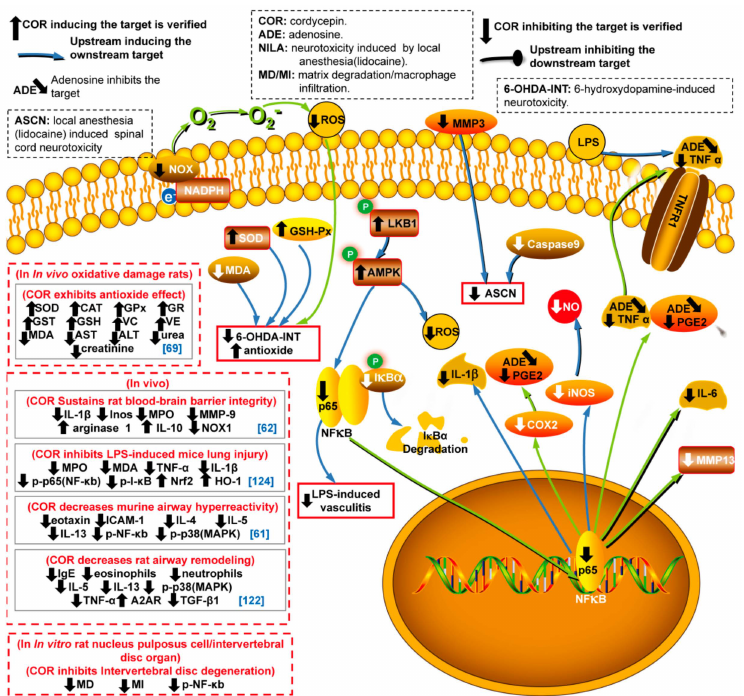
Figure3. Anti-inflammatoryandanti-oxidanttargetsa ff ectedbycordycepinviavarioussignalpathways. Note: SOD: superoxide dismutase. GSH-Px: glutathione peroxidase. MDA: malondialdehyde. 6-OHDA-INT:6-hydroxydopamine-induced neurotoxicity. VC: Vitamin C. VE: Vitamin E. IL-1 β : interleukin-1 beta. iNOS: inducible nitric oxide synthase. PGE2: prostaglandin E2. NO: nitric oxide. COX-2: cyclo-oxygenase. NF- κ B: nuclear factor kappa-B. iNOS: inducible nitric oxide synthase. IgE: immunoglobulin E. ICAM-1: intercellular cell adhesion molecule-1. HO-1: heme oxygenase-1. These abbreviations are also used in this